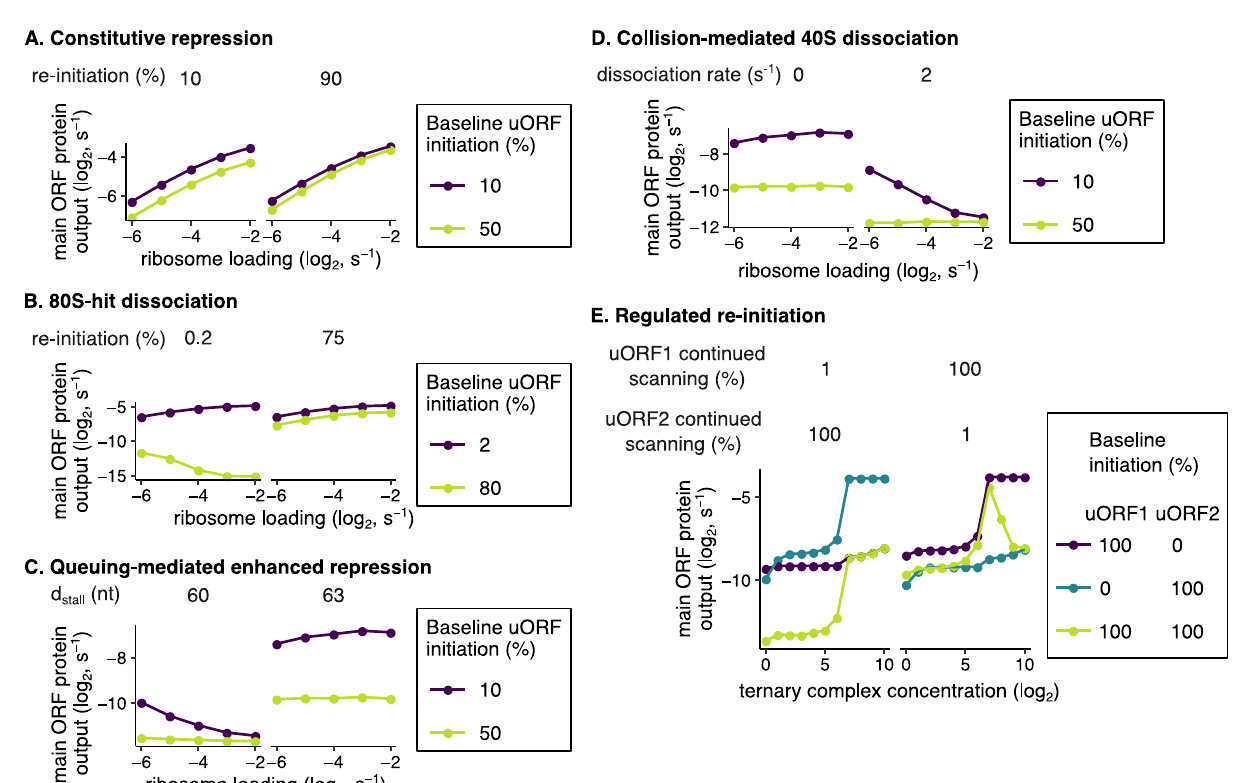
Fig 4. Kinetic modeling predicts translational buffering by uORFs. Buffering refers to a smaller than expected decrease (small positive slope), or even increase (negative slope), in main ORF protein output with reduced ribosome loading. (A) The constitutive repression model, without an elongating ribosome stall, has no buffering behavior. uORFs simply siphon away scanning ribosomes from the main ORF. (B) Buffering in the 80S-hit dissociation model depends on uORF initiation and re-initiation frequencies [38]. For buffering to occur in this model, uORFs must initiate well enough to have elongating ribosomes hit 3 0 scanning ribosomes (yellow-green line). uORFs must also not continue scanning at high frequencies following termination (left panel); frequent continuation of scanning coupled with high uORF initiation allows many scanning ribosomes to make it to the main ORF. Buffering occurs better for longer uORFs that have more time for elongating ribosomes to hit 3 0 scanning ribosomes (S2A Fig, yellow-green line). Here, the uORF is 100 codons long. The dissociation rate is 200s − 1 , so 99% of scanning ribosomes hit by 5 0 elongating ribosomes dissociate rather than continue scanning. The scanning rate is 2 nucleotides/s, and the elongation rate is 2 codons/s. There is no elongating ribosome stall in this model. (C) Buffering in the queuing-mediated enhanced repression model depends on d : the distance between the uORF start codon and elongating ribosome stall stall. In this model, uORF initiation can increase above baseline with increased ribosome loading when d stall is an integer multiple of the ribosome footprint (30 nt, left panel). When this condition is met, buffering occurs. For d values of 60 and 63 nt, the uORF length is 21 and 22 codons, stall respectively. (D) Buffering in the collision-mediated 40S dissociation model depends on the dissociation rate. Here, d stall is 63 nt; with a low dissociation rate, this model reduces to the queuing-mediated enhanced repression model. (E) Buffering in the regulated re-initiation model depends on uORF initiation and continued scanning frequencies. For buffering to occur, several conditions must be met. At least 2 uORFs are required, both of which must be well-translated (yellow-green line). Continued scanning following termination at the first uORF must be frequent, and continued scanning following termination at the second downstream uORF must be rare (right panel). The second downstream uORF is 3 codons long. There is no elongating ribosome stall in this model. uORFs are located 25 nt from the 5 0 cap. 99% of scanning ribosomes that make it to the main ORF will initiate translation; 1% will leaky scan. Unless otherwise stated, parameters (Table 1) obtained from calibrating models to reporter measurements on wild-type or mutant uORF2 (Fig 2C) are used here. Ribosome loading is the k cap bind rate for non-regulated re-initiation models. We model changes in ribosome as that rate is easier to match to in vivo estimates of ribosome loading. However, buffering in the regulated re-initiation loading via changes in k cap bind model is dependent on an eIF2 α phosphorylation mechanism; we instead vary the number of ternary complexes in this model. Error bars of simulated data are smaller than data